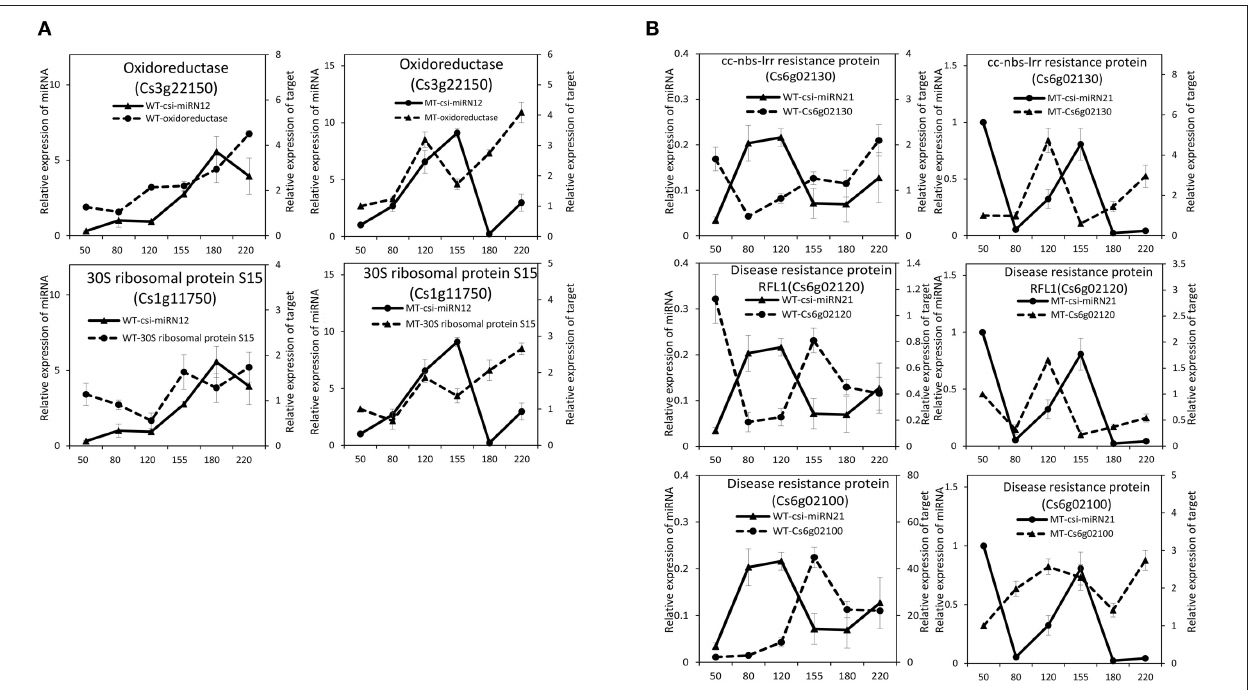
FIGURE 6 | Expression patterns of novel miRNAs and their target genes in MT and WT during fruit development and ripening. (A) , csi-miRN12; (B) ,